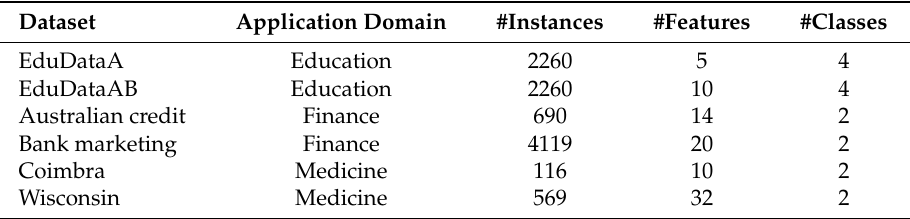
Table 1. Benchmark datasets